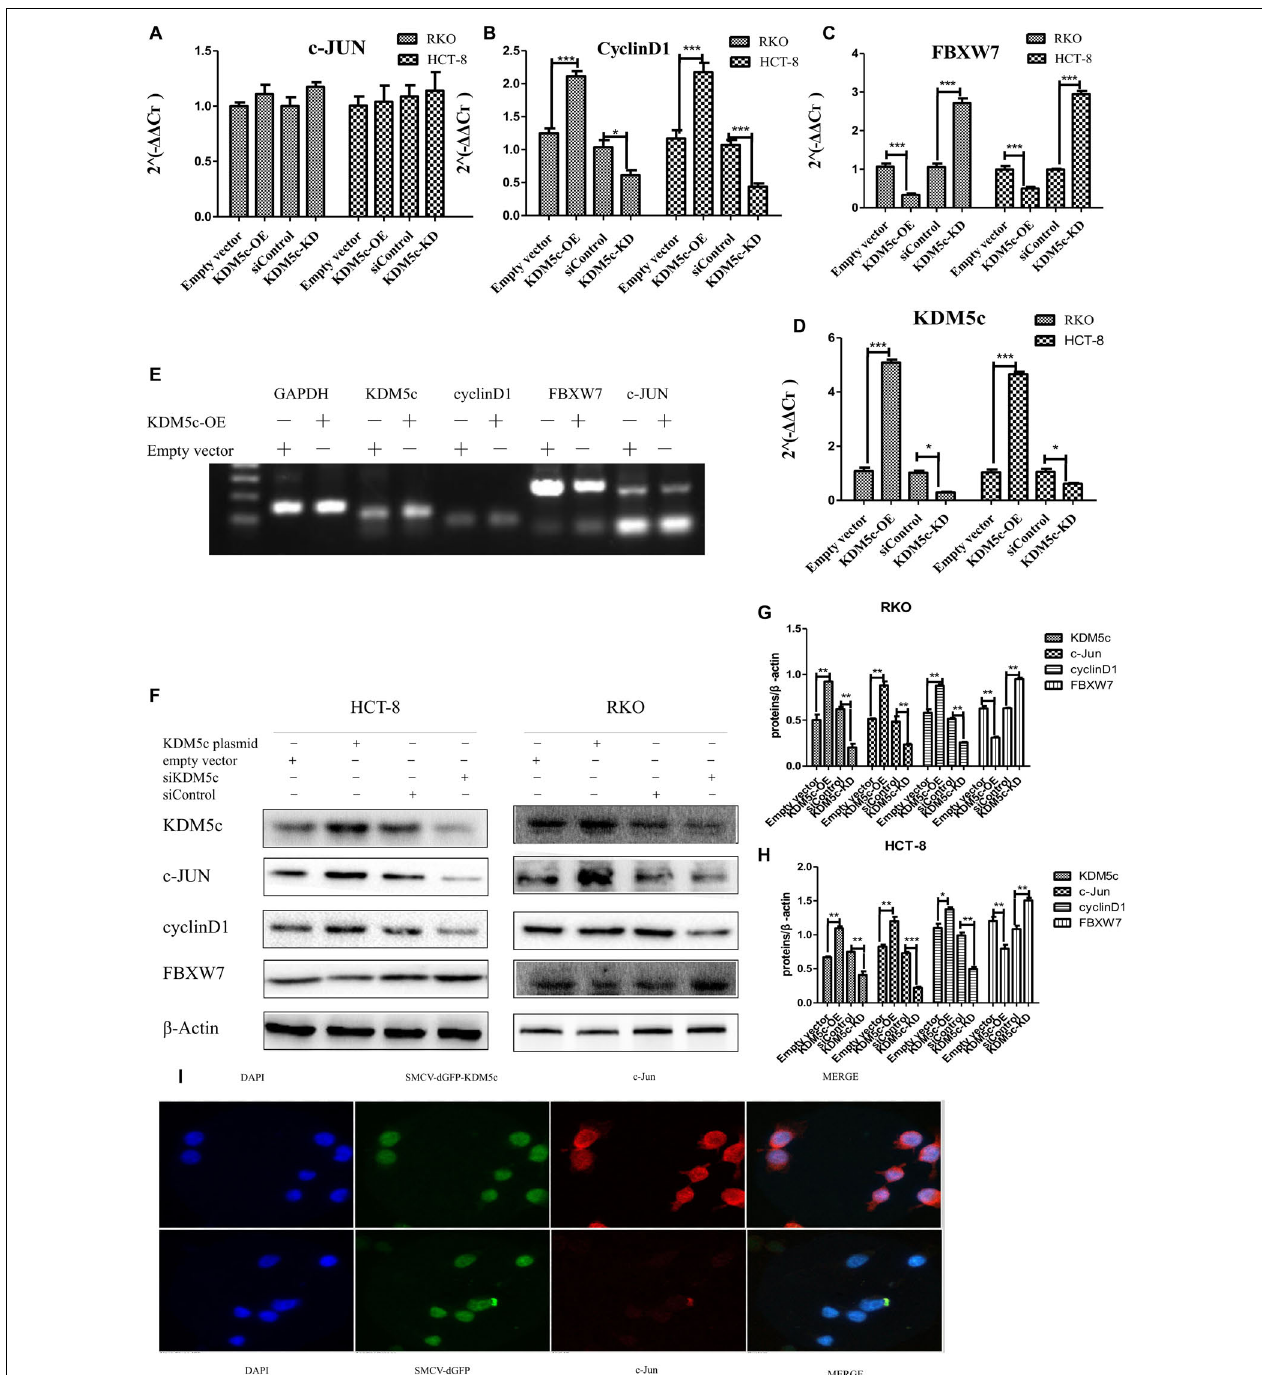
FIGURE 2 | KDM5c overexpression modified downstream gene expression. (A–D) Quantitative PCR (qPCR) data of c-Jun (A) , Cyclin D1 (B) , FBXW7 (C) , and KDM5c (D) expression in RKO and HCT-8 cells that were transfected with the empty vector (Control), KDM5c-SMCV (KDM5c-OE), siRNA (siControl), and siKDM5c. (E) RT-PCR results showing the kinetic transcription levels of KDM5c, cyclin D1, and FBXW7. (F–H) Western blot (F) and qualification (G,H) analysis showing that the overexpression of KDM5c in both RKO and HCT-8 cells increased c-Jun and cyclin D1 but reduced FBXW7 protein levels. The level of β -Actin was detected as the loading control. (I) Immunofluorescence indicates that HCT-8 cells transfected with MSCV-dGFP-KDM5c expressed more c-Jun than those transfected with MSCV-dGFP-null. The presented data are from two independent experiments. Upper panel: staining of HCT-8 overexpression of KDM5c. Lower panel: cell nucleus (blue), KDM5c (green), and c-Jun (red) staining of HCT-8 transfected with the empty vector. Merge: cell nucleus (blue), KDM5c (green), and c-Jun (red) overlap. Scale bar = 25 µ m. Data indicate the mean ± SD from four technical replicates. Non-significant, P > 0.05; * P ≤ 0.05; ** P ≤ 0.01; *** P ≤ 0.001. This experiment was repeated three times with similar